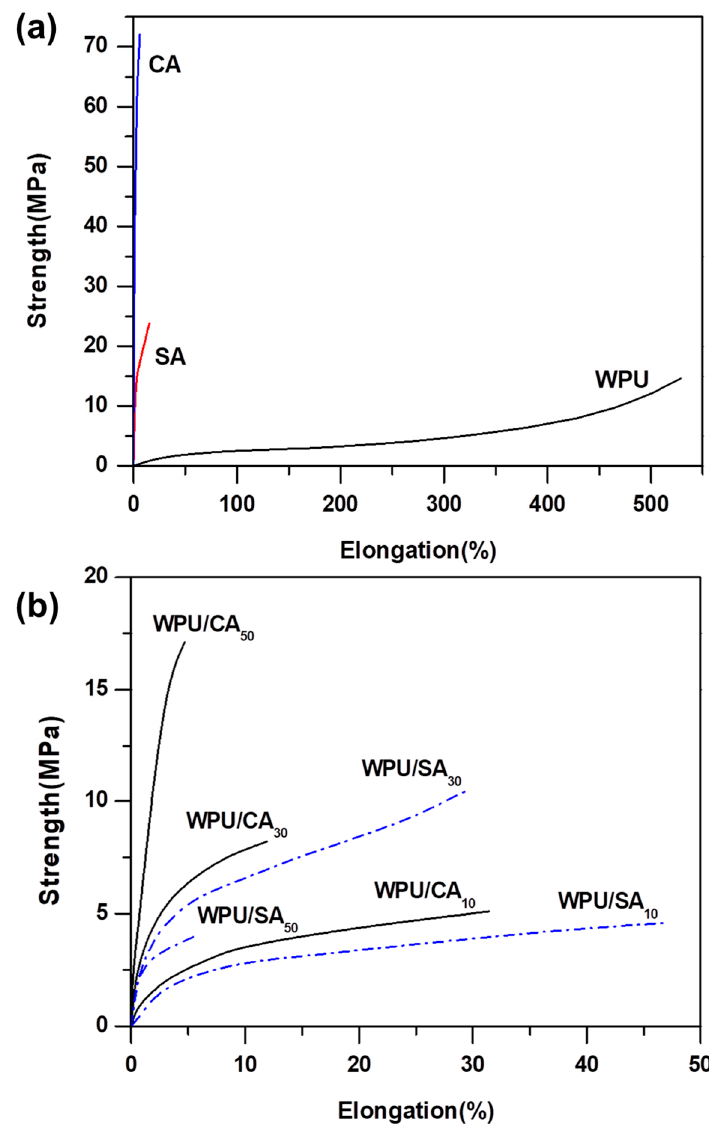
Figure 5. Tensile strength curves of the CA, SA, and WPU blend ( a ) and the WPU/SA and WPU/CA blends ( b ). Table 3. Tensile strengths of the WPU, SA, CA, WPU/SA, and WPU/CA blends.